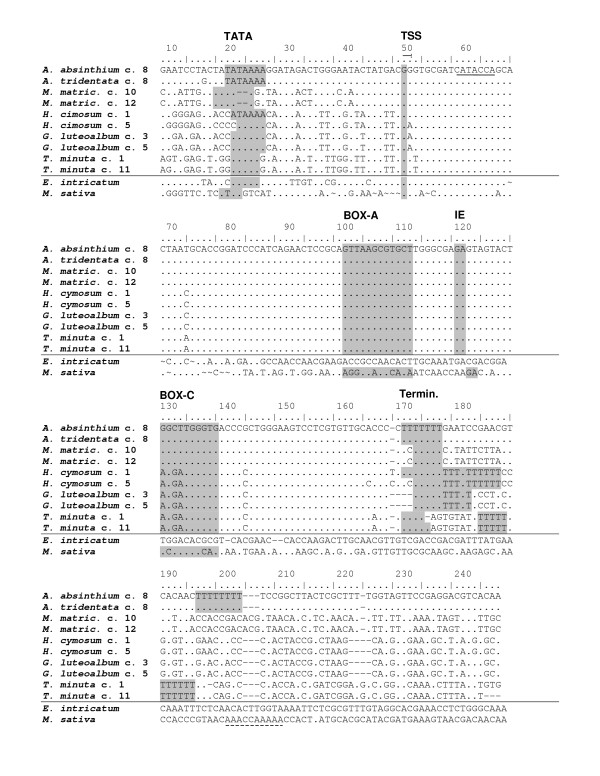
Alignment of 5S genic regions and flanking sequences. Conserved regulatory motifs essential for the polymerase III transcription [51] are highlighted. The insertions with complete and incomplete 5S copies are separated by a horizontal line. Note the highly conserved genic regions are well separated from the highly diverged 5' and 3' sequence ends. The 3' flanking sequences are only partially aligned because of the divergence. The numbers after the species name in titles indicate clones. TATA - TATA box; TSS - transcription start site; IE - internal regulatory element; Termin. - transcription terminator. The bottom strands (with respect to the 26S gene transcription) are shown except for Madia sativa. Underlined solid line - a motif resembling reverse transcriptase primer binding site (methionine tRNA). Underlined dashed line - a motif resembling a polyadenylation site.